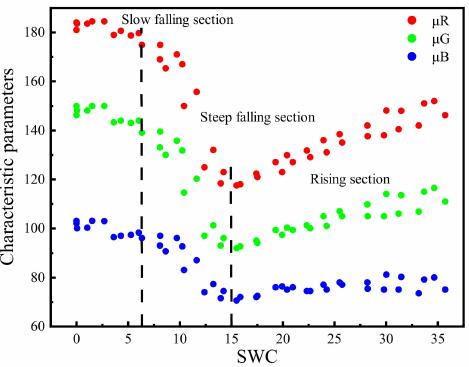
Figure 13. Curves of relationships between characteristic parameters from RGB color space and